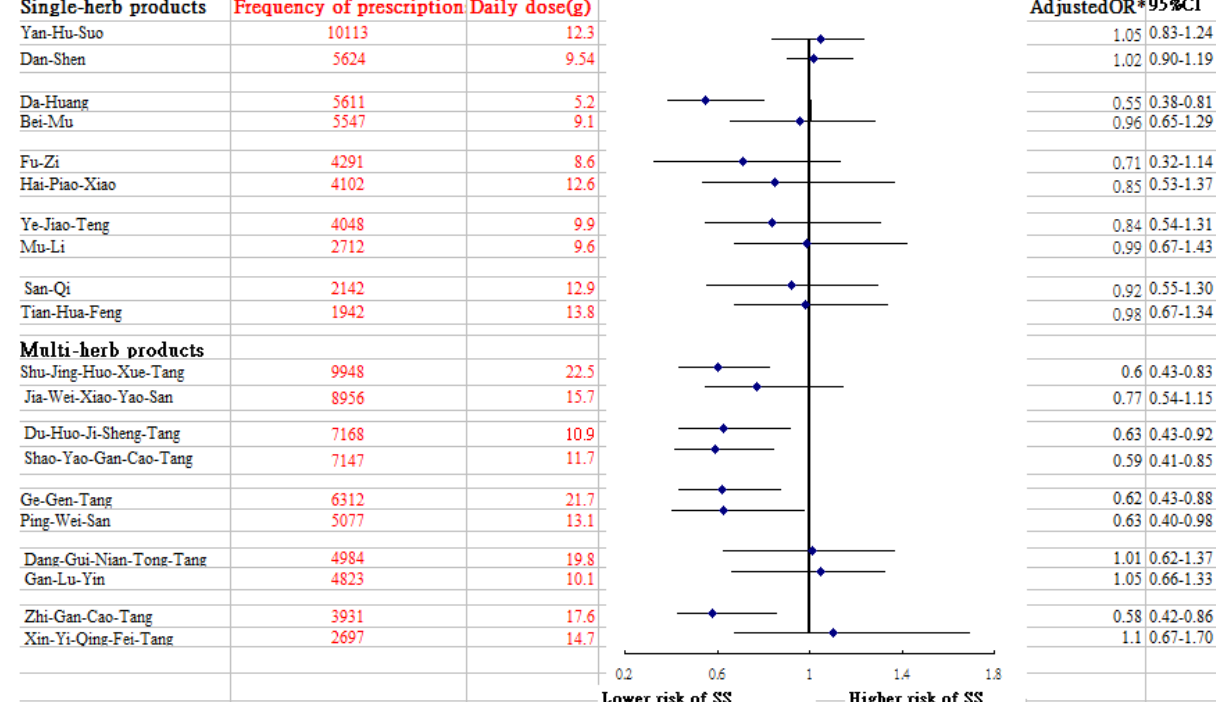
Figure 2. Risk of SS in relation to the 10 most-used single-herb and multi-herb CHM products for RA patients. * Model adjusted for age, residential area, monthly income, medication use and CCI.